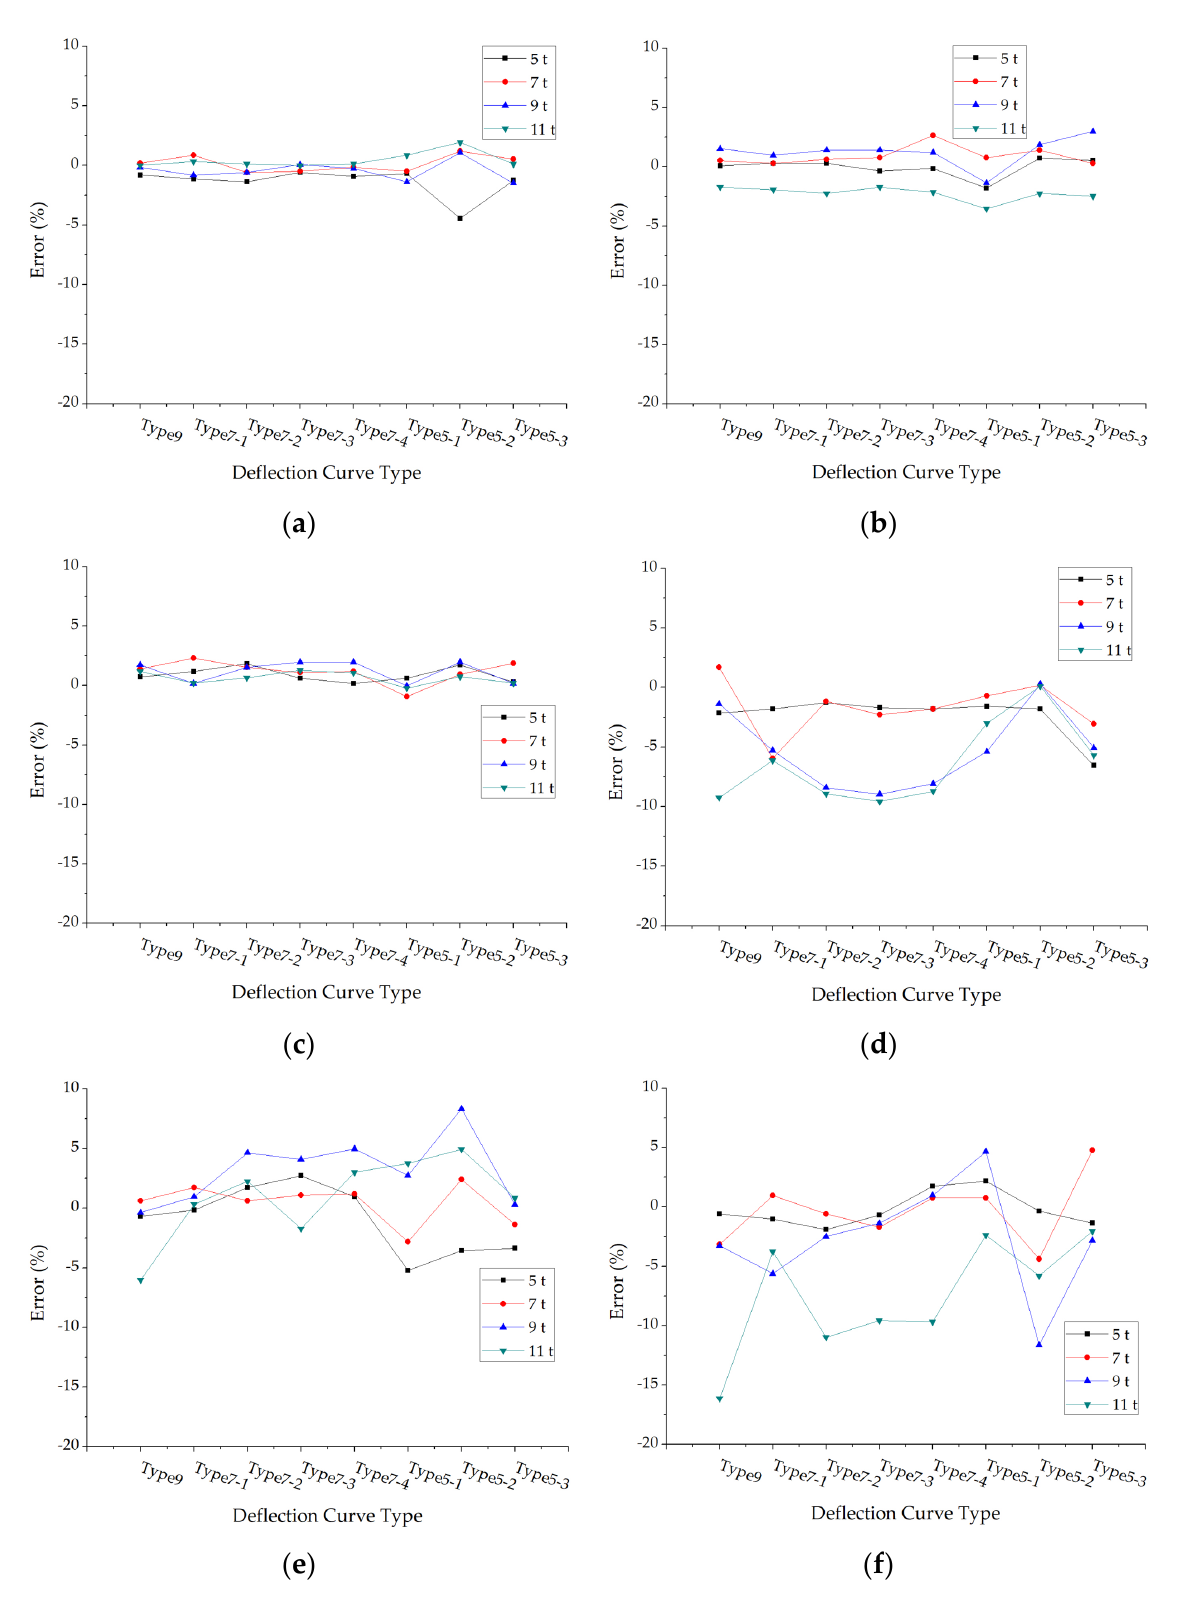
Figure 7. The errors of back calculated base modulus under different deflection curve types: ( a ) Structure 1; ( b ) Structure 2; ( c ) Structure 3; ( d ) Structure 4; ( e ) Structure 5; ( f ) Structure 6.